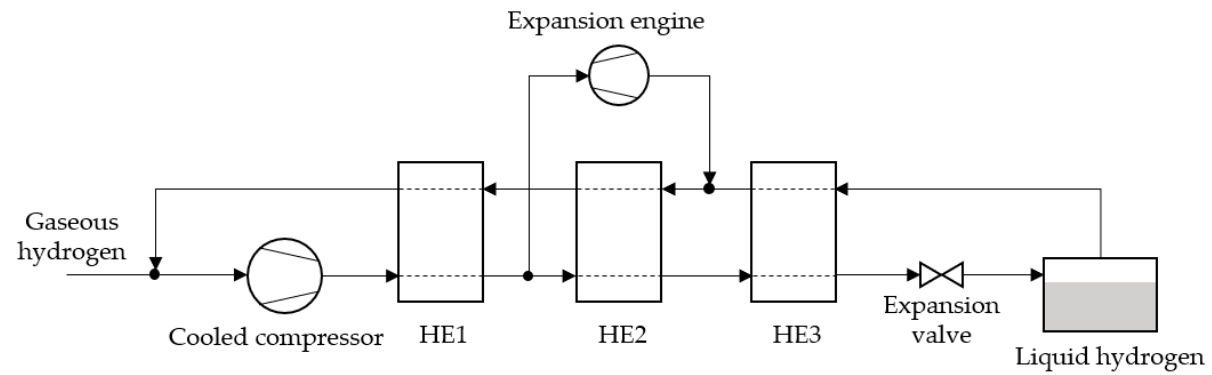
Figure 6. Basic schematic diagram of Claude process for hydrogen liquefaction [69].